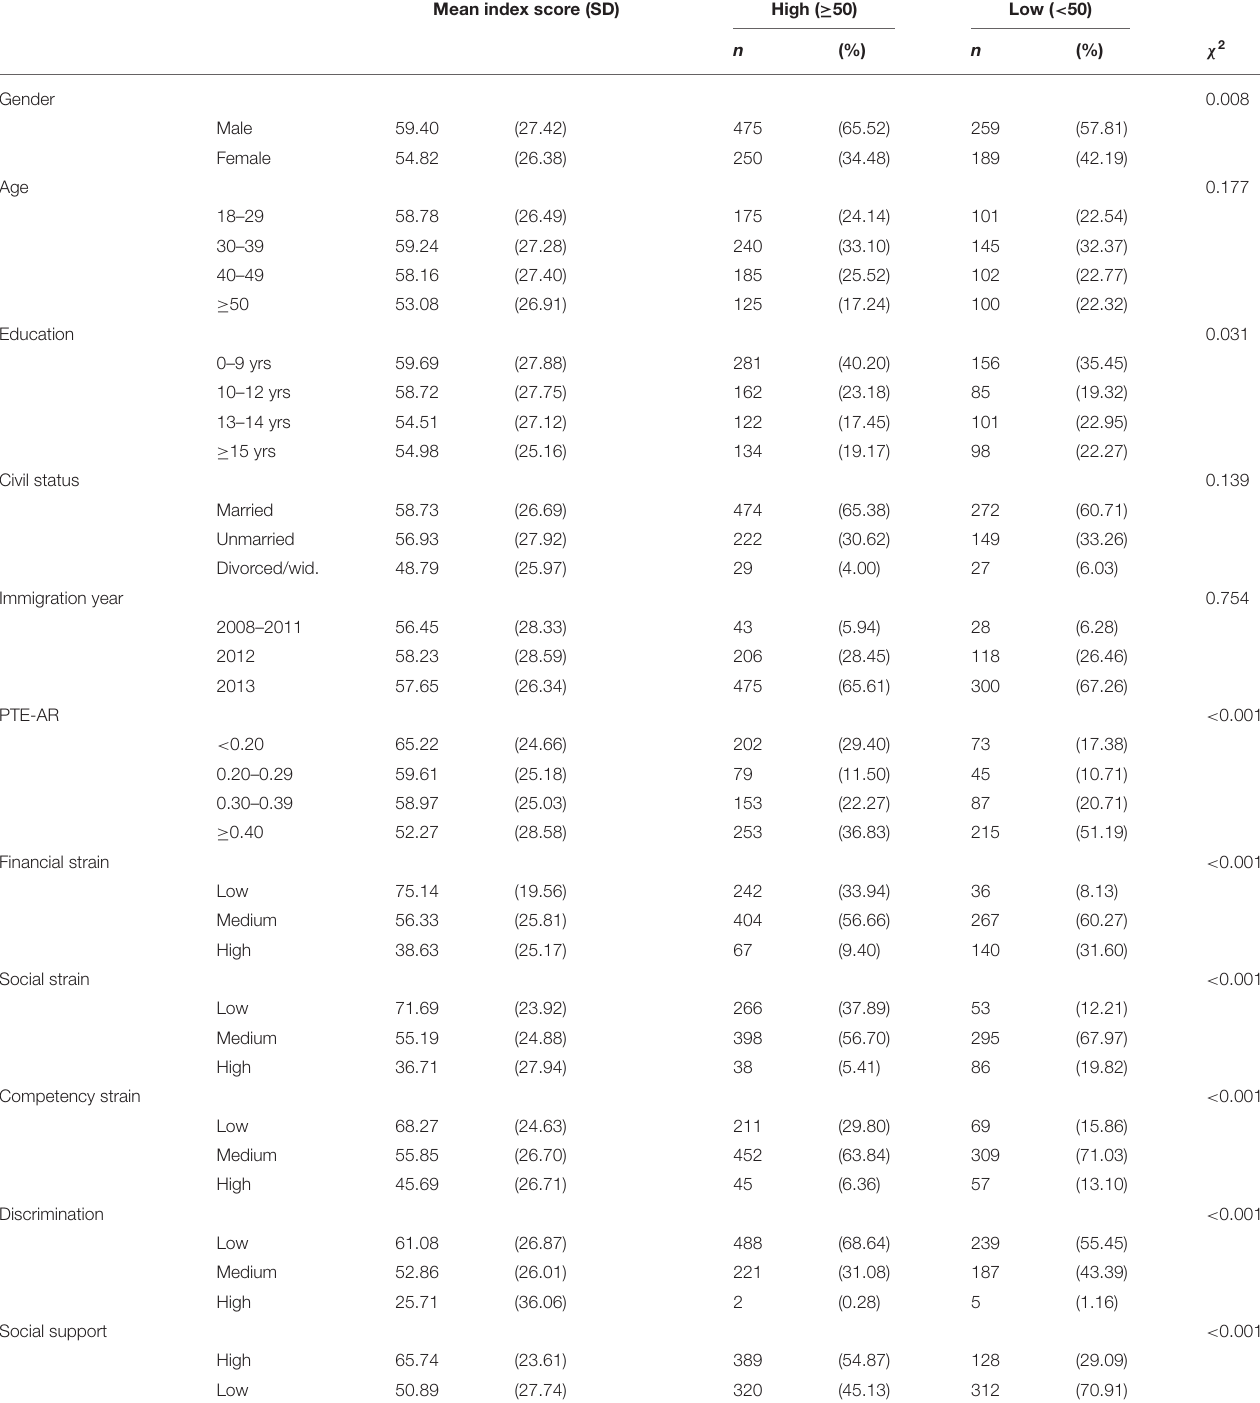
TABLE 2 | Summary of WHO-5 Well-Being Index (0-100), mean (SD) and dichotomized into high vs. low subjective well-being